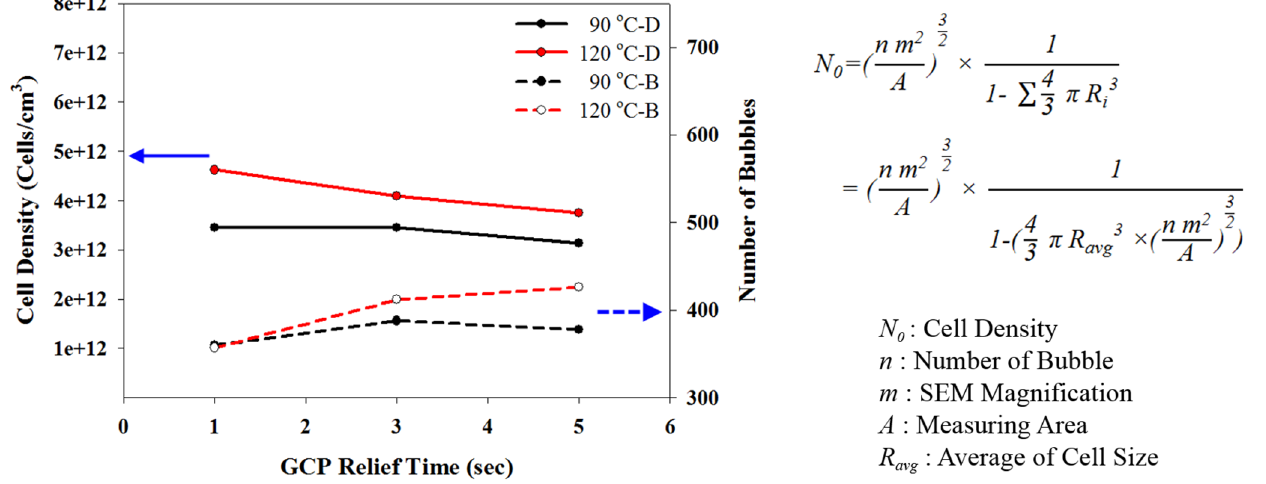
Figure 11. Effects of GCP relief time on foaming cell density. A schematic of cell density calculation from bubble numbers shown in the Scanning Electron Microscope photograph is also presented.